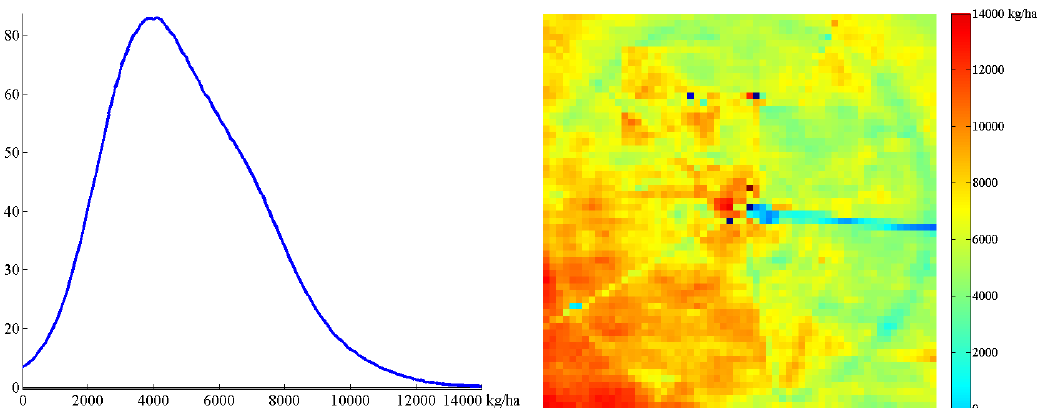
Figure 9. The distributions of yield estimated by the data assimilation approach with sample data.